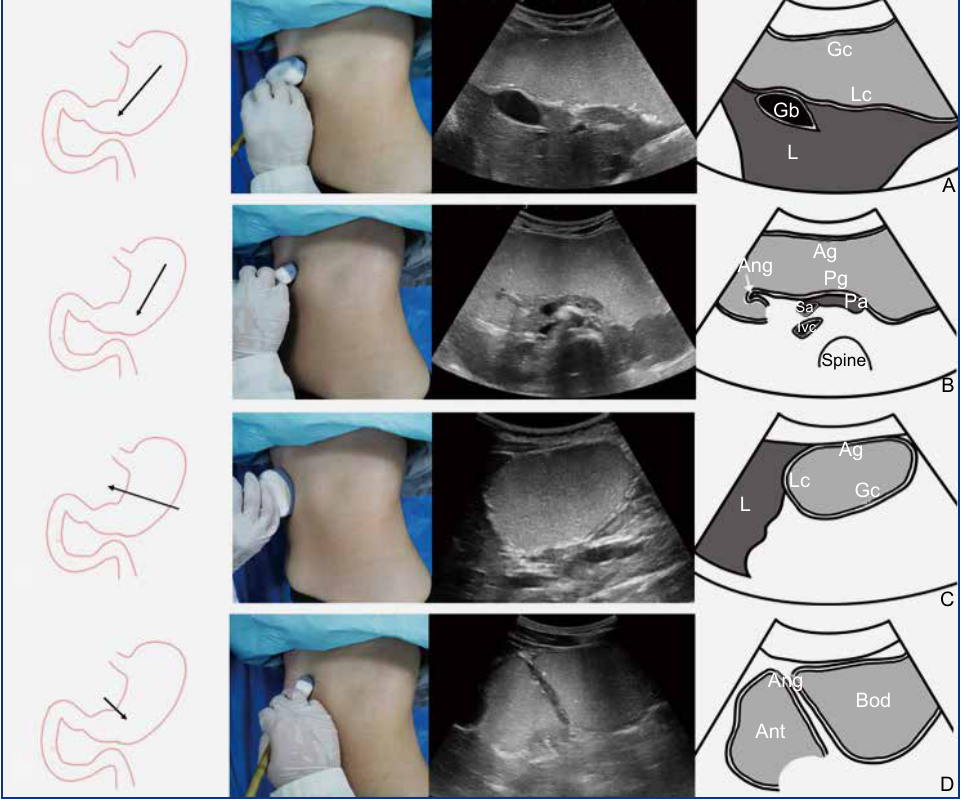
Figure 4 The imaging sections of gastric body. (A) The long-axis section of the greater and lesser curvature of the stomach (Vertical transverse view of the upper abdomen in the right lateral position); (B) The long-axis section of gastric body (vertical transverse section of upper abdomen in right lateral position); (C) The short-axis section of gastric body (vertical transverse section of upper abdomen in right lateral position); (D) The transverse section of gastric horn (oblique longitudinal section of upper abdomen in right lateral position). Gc, greater curvature; Lc, lesser curvature; Gb, gallbladder; L, liver; Ag, anterior gastric; Ang, gastric angle; Pg, posterior gastric; Pa, pancreas; Bod, gastric body; Ant,